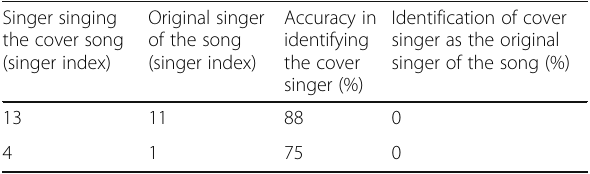
Table 5 Experimentation to find the cover